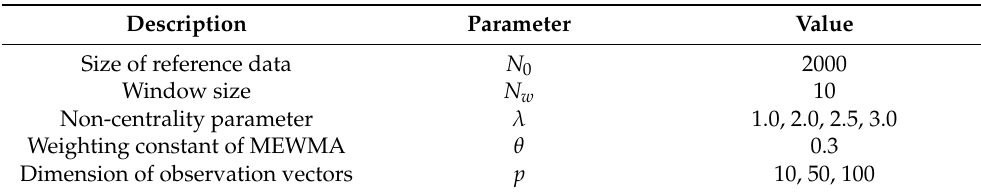
Table 1. Experiment